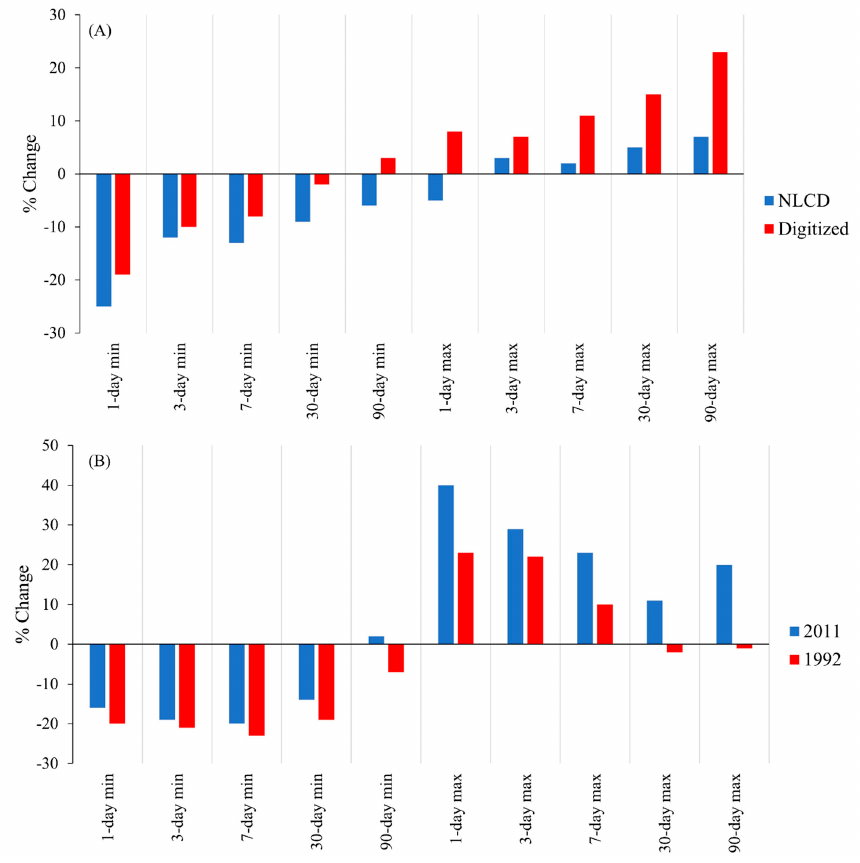
Figure 6. Changes in annual extreme water conditions. Percent differences in the magnitude of extreme water conditions due to the source of LULC data ( A ) and due to the temporal condition of LULC distribution in the watershed using 1992 and 2011 LULC data ( B ).